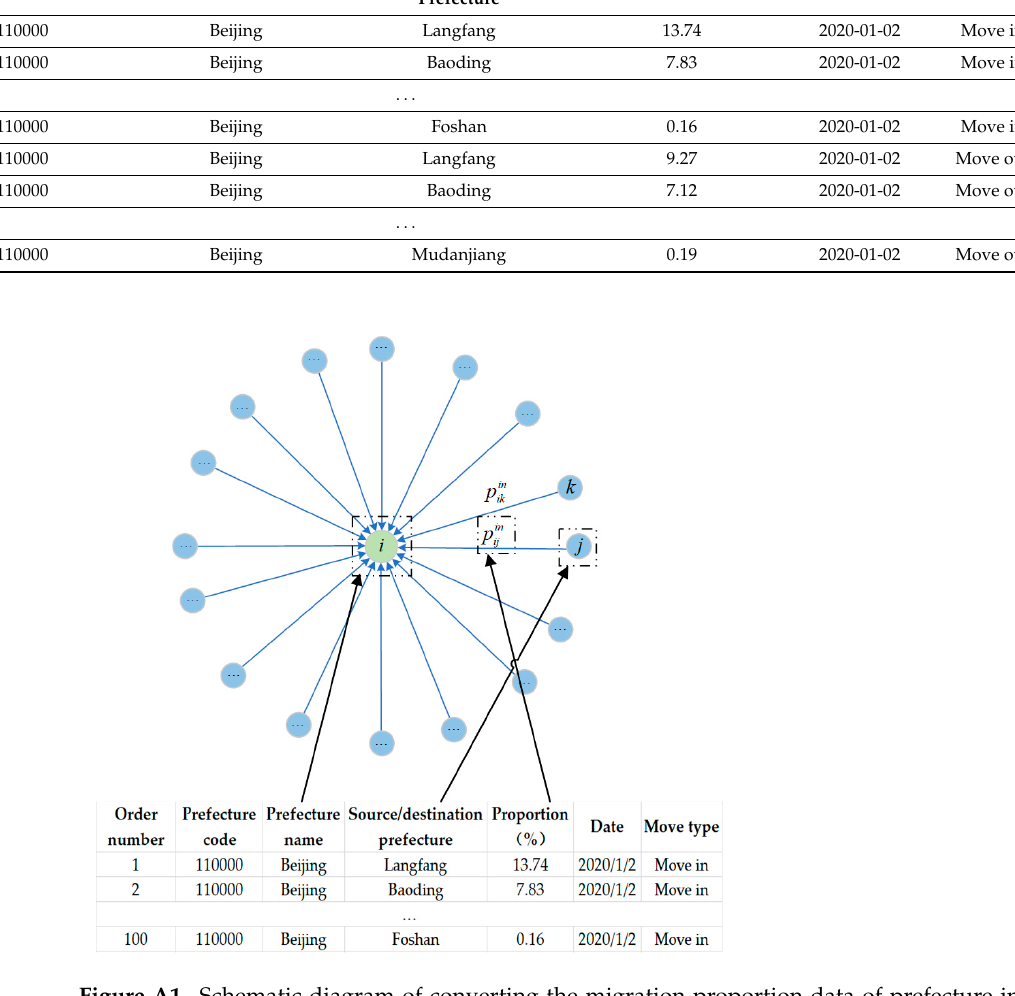
Figure A2. Schematic diagram of epidemic simulation model. ( a ) Schematic diagram of compart- ment model; ( b ) schematic diagram of a mobility network composed of three subpopulations.